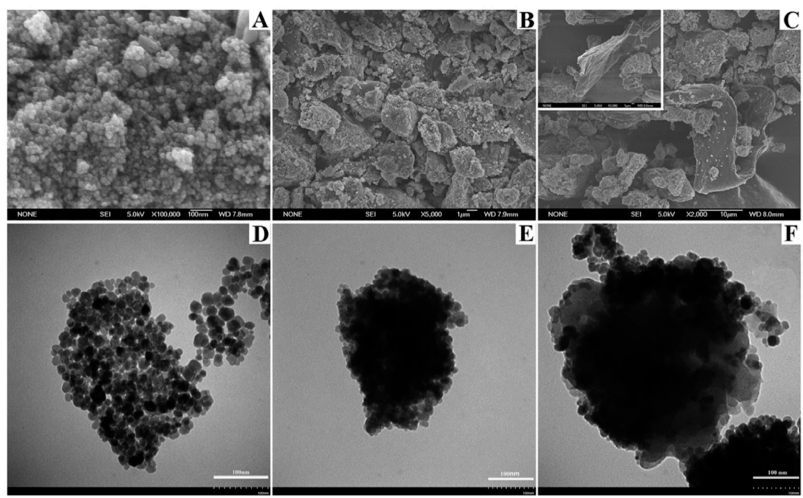
Figure 6. SEM images of Fe 3 O 4 ( A ), Fe 3 O 4 @HKUST-1 ( B ), Fe 3 O 4 @HKUST-1@PDES ( C ), and TEM images of Fe 3 O 4 ( D ), Fe 3 O 4 @HKUST-1 ( E ), Fe 3 O 4 @HKUST-1@PDES ( F ). Adapted with permission from [76]. Copyright (2019) Elsevier.